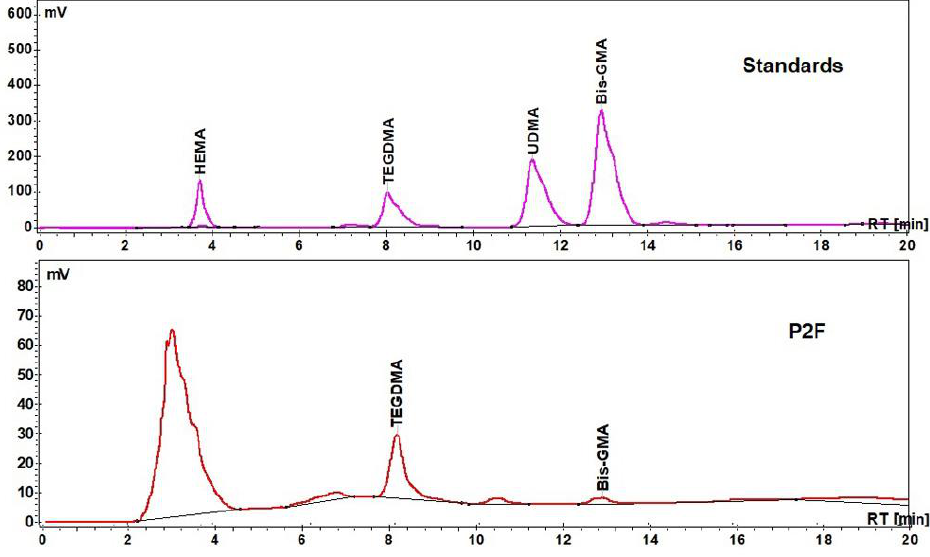
Figure 7. The HPLC chromatograms of standards (Bis-GMA, TEGDMA, HEMA, and UDMA) and an extract of the experimental infiltrant (P2F). extract of the experimental infiltrant